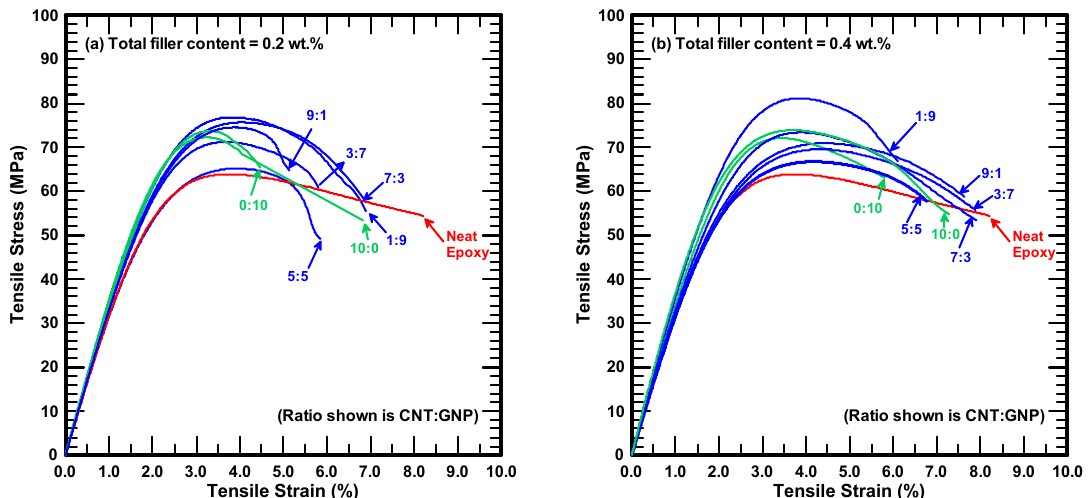
Figure 3. Stress-strain curves for the studied nanocomposites with total filler contents of ( a ) 0.2 wt %, b ) 0.4 wt ( b ) 0.4 wt %. (